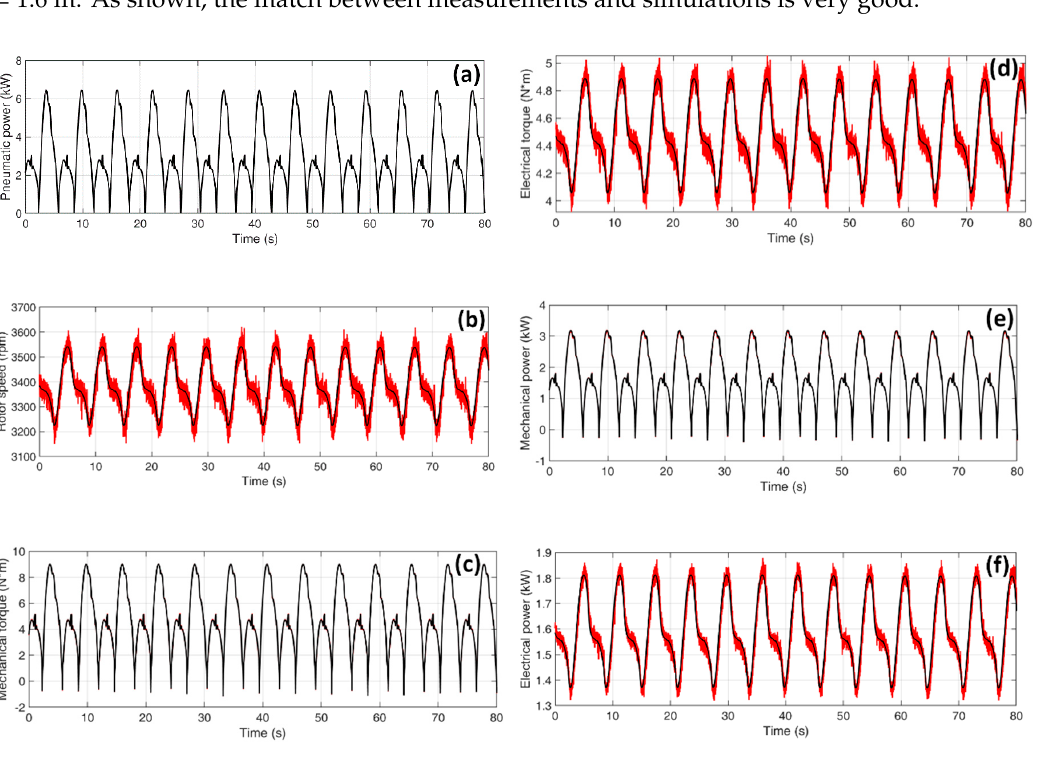
Figure 16. Simulated (black traces) and measured (red traces) variables: ( a ) pneumatic power; ( b ) rotor speed; ( c ) mechanical torque; ( d ) electrical torque; ( e ) mechanical power; ( f ) electrical power. Sea state: H s = 1.6 m, T s = 5.1 s. Turbine: Impulse. Control law: